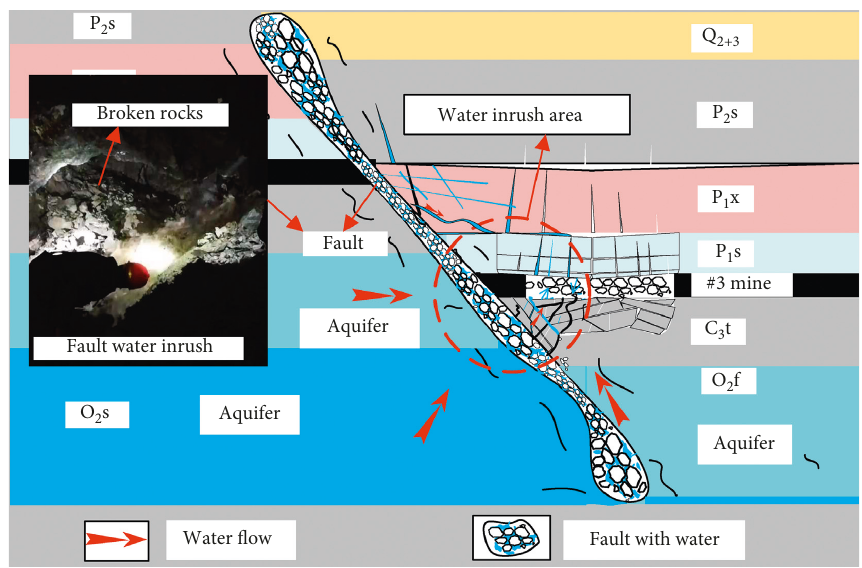
Figure 1: Description about fault water inrush in